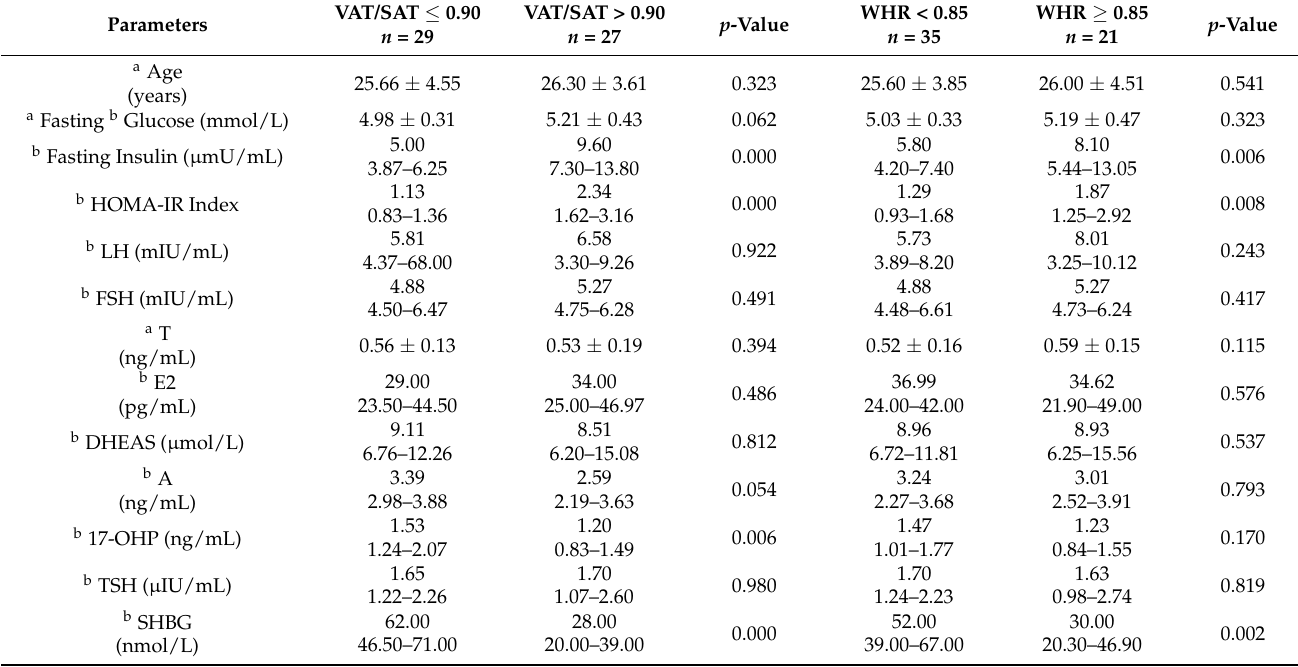
Table 1. Baseline clinical features in women with PCOS divided according to the visceral to subcuta- neous fat surface ratio and the waist-to-hip